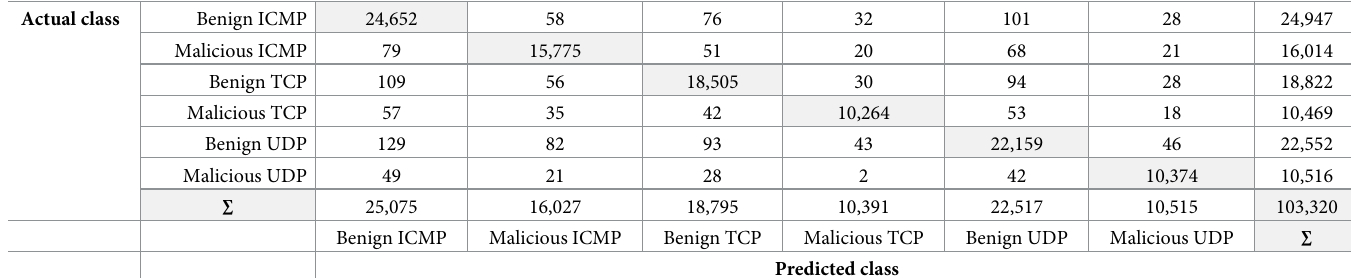
Table 11. Confusion matrix of SDN dataset.